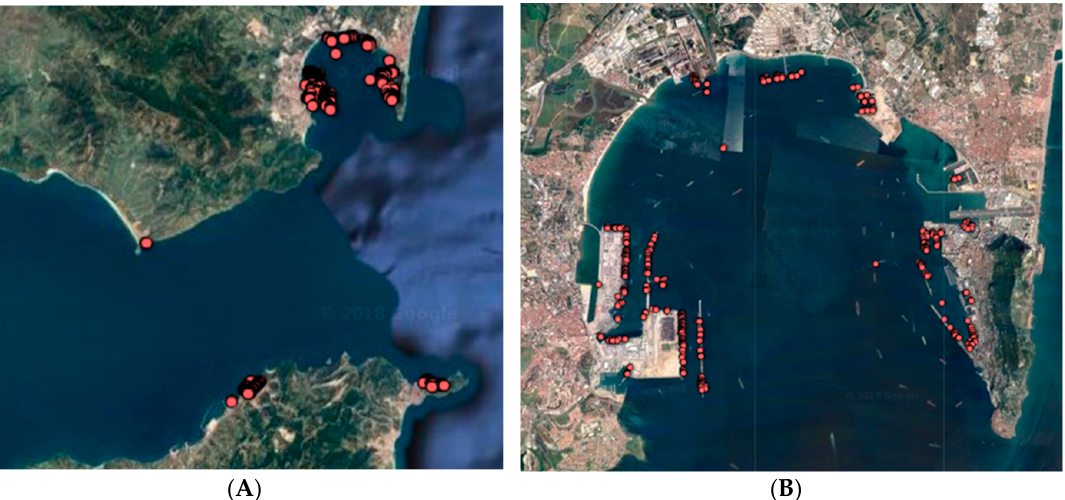
Figure 10. ( A ) Berths / OD events detected over the Strait of Gibraltar. ( B ) Berths / OD events in Bay of Gibraltar, which is in the upper right corner of the left figure.